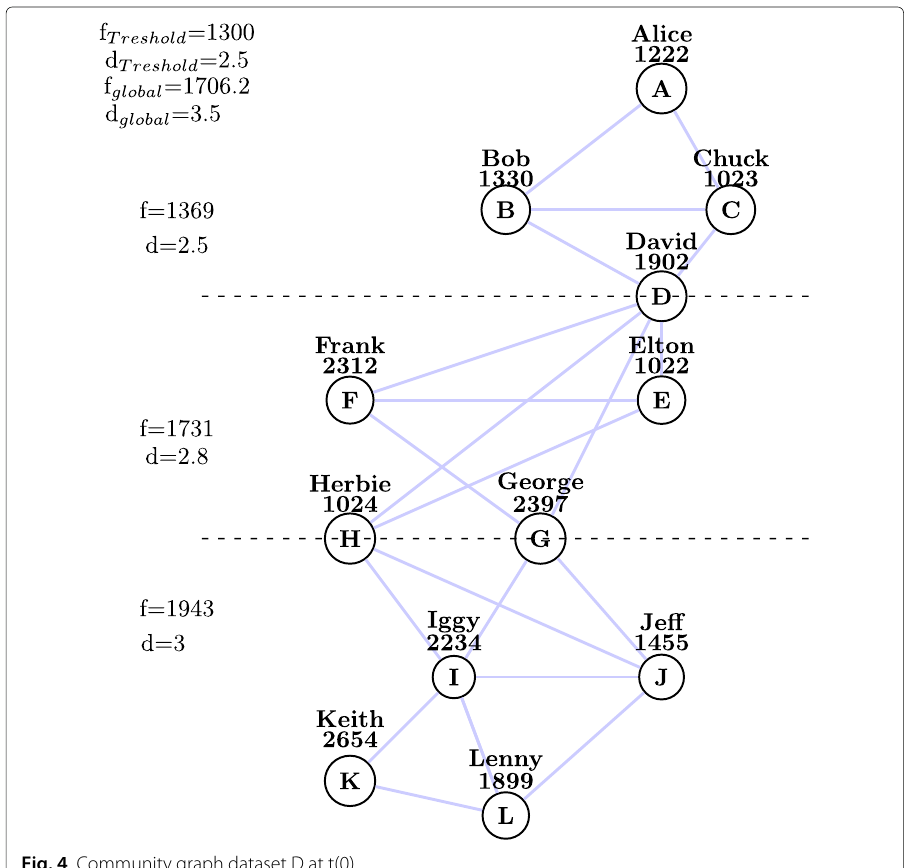
Fig. 4 Community graph dataset D at